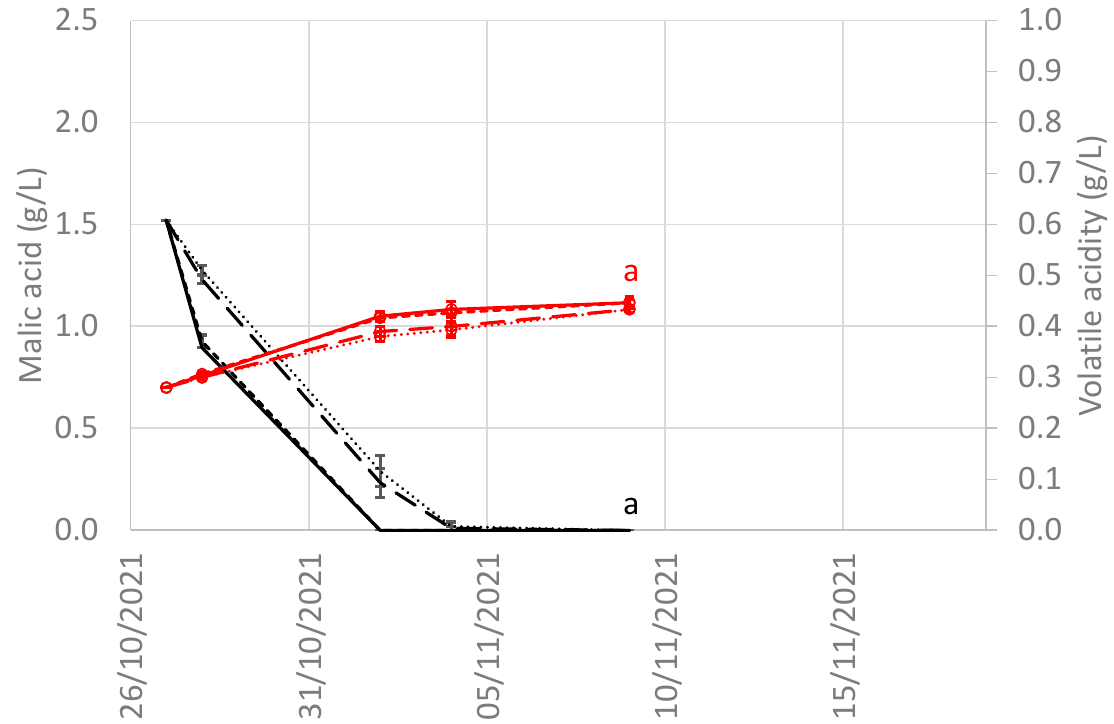
Figure 2. Evolution of malic acid (black lines) and volatile acidity (red lines with circles) (g/L) in spontaneous or inoculated (alpha, O. oeni ) MLFs with or without FH2 inhibition (600 mg/L) for trials performed in triplicate during 2021. Malic acid in control ( ), control with FA ( ), control with LAB ( ), and control with FA and LAB ( ). Volatile acidity in control ( ), control with FA ( ), control with LAB ( ), and control with FA and LAB ( ). ( A , B ) red wines from Tempranillo and Garnacha, respectively, ( C ) rose, ( D ) white wine. Values are the means and bars are standard deviations of three independent fermentations. Letters of last day represent sig- nificant differences.